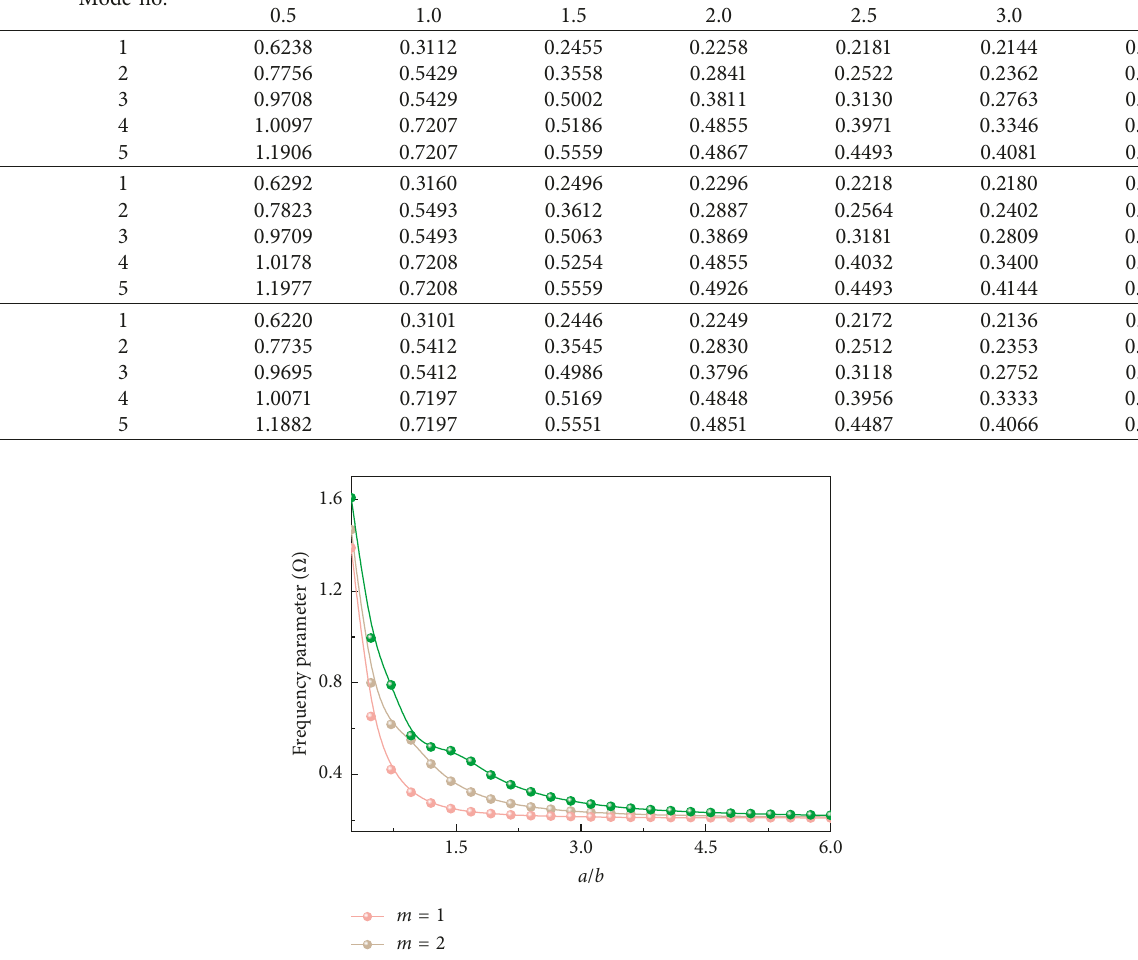
Table 7: Nondimensional frequency parameter Ω of porous rectangular plates with different aspect ratios (CCCC) ( e � 0.2 and h/b � 0.2). Type Mode no.